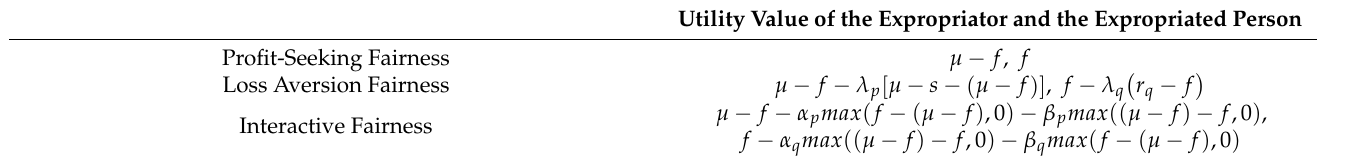
Table 4. Compensation scheme for urban housing expropriation 1 (fair expropriation, acceptance). Utility Value of the Expropriator and the Expropriated Person